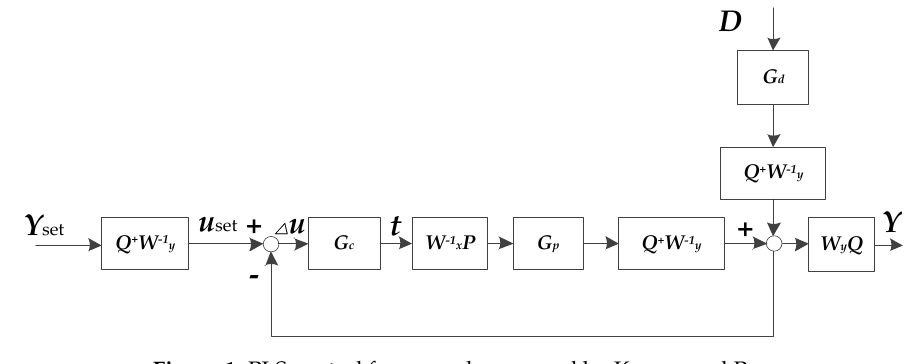
Figure 1. Unlike conventional control methods, the controllers